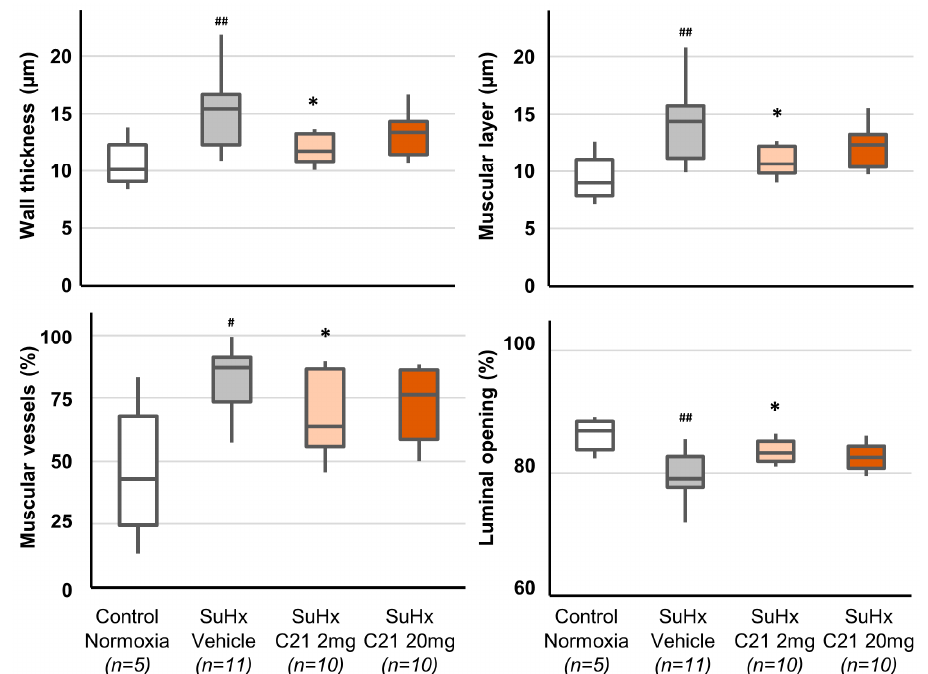
Figure 3. Wall morphology in vessels >100 µm. The box and whiskers represent the median, interquartile range, minimum and maximum values. # p < 0.05 and ## p < 0.01 compared with normoxic animals (Mann–Whitney U-test). * p < 0.05 compared with SuHx Vehicle animals (Kruskal–Wallis test).